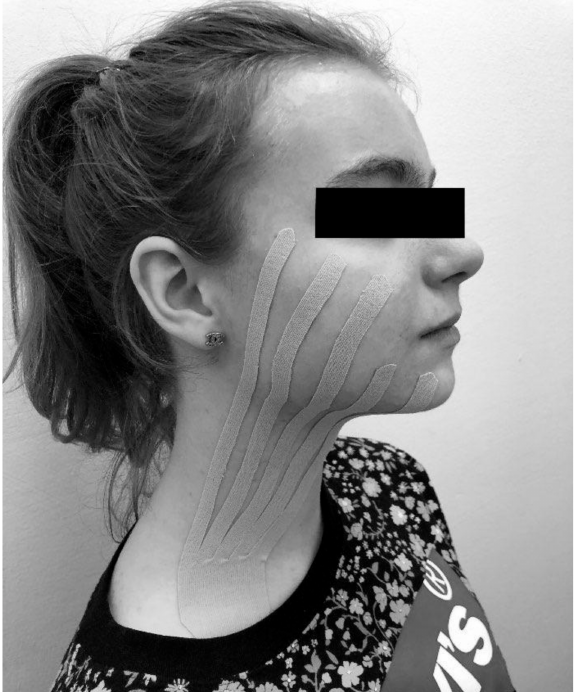
Figure 3. An example of the taping method performed on a test group